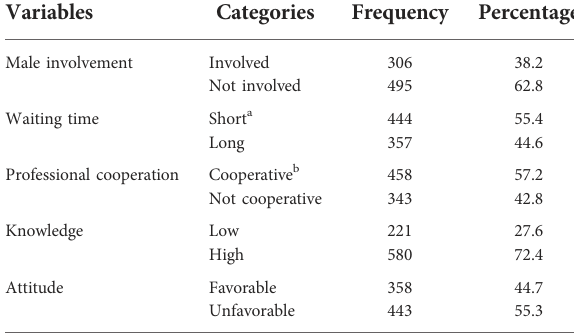
TABLE 3 Prevalence of male involvement, service delivery experience, knowledge, and attitudes of male partners of women